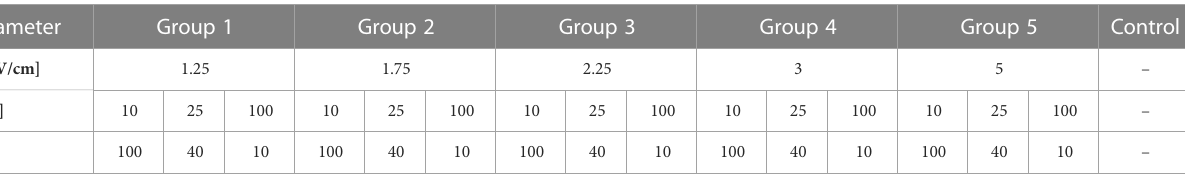
TABLE 1 Parameters of